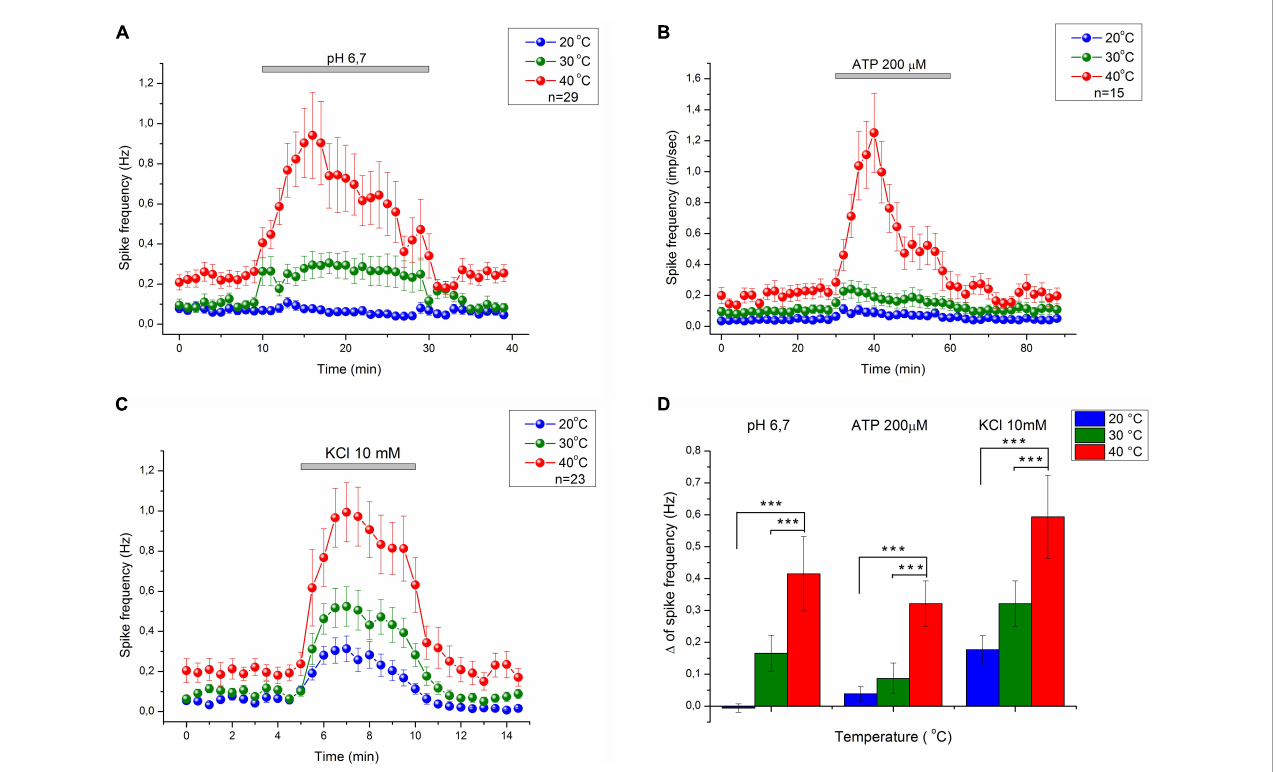
FIGURE3 The average response of CMH nociceptors to low bicarbonate buffer solution (pH = 6.7) (A) , ATP 200 µ M (B) , and K + 10.8 mM (C) in mice skin-nerve preparation at 20, 30, and 40 ◦ C. C-fibers nociceptors displayed an increasing response to nociceptive agents: ATP, low pH, and high K + concentration with increasing temperature. The value of spikes frequency in response to high K + , low pH, and ATP, was highest at 40 ◦ C and lowest at 20 ◦ C. (D) Difference between MEAN of spikes frequency during chemical stimulation and control recording– (cid:49) (delta) at 20, 30, and 40 ◦ C. *** p <